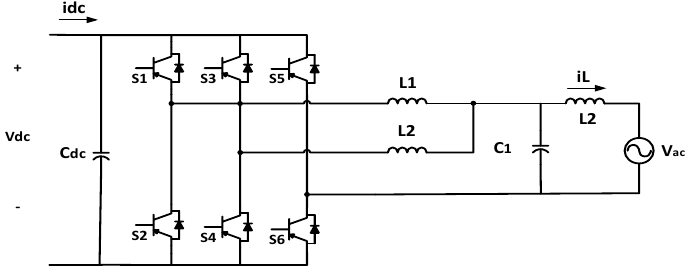
Figure 9. Interleaved single-phase three-leg of full bridge topology [39].